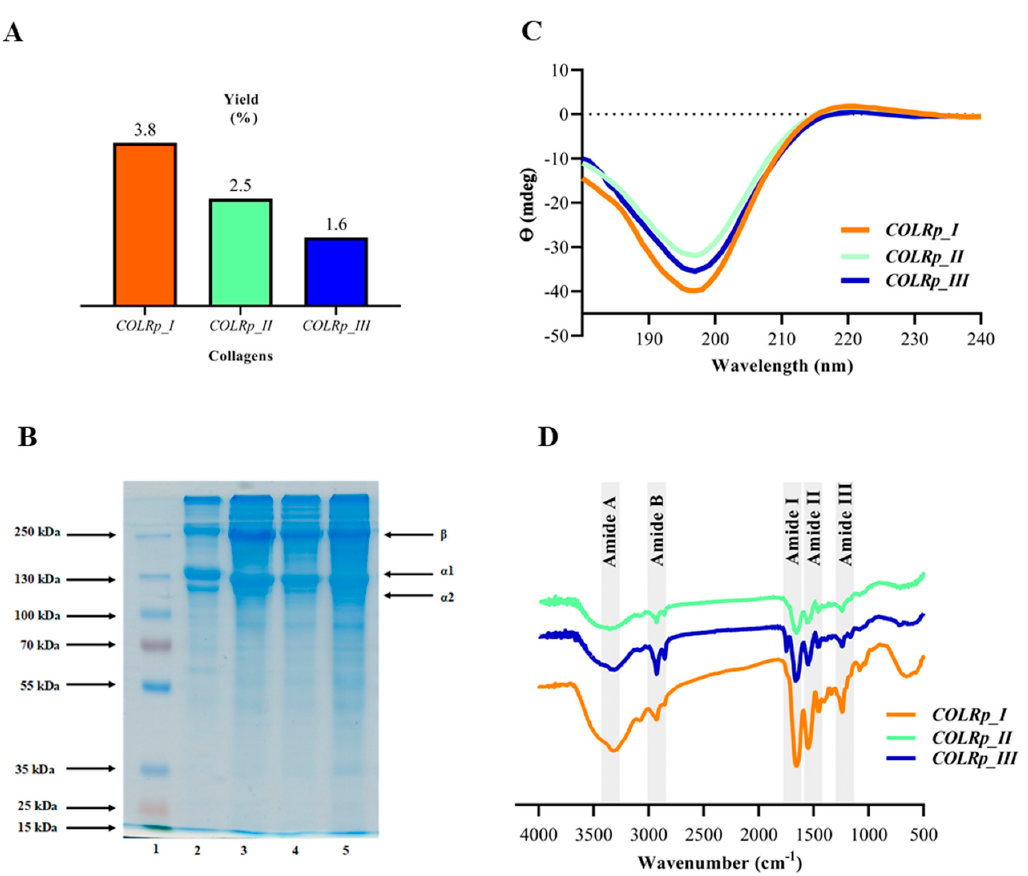
Figure 2. Results from the characterization of R. hippoglossoides fish collagens isolated from skin byproducts using three methods. ( A ) Extraction yield. ( B ) SDS-PAGE gel patterns, whereas number 1 represents protein molecular weight marker; 2 denotes standard collagen from bovine skins ( COL_Bovine ); 3, 4, and 5 represent COLRp_I , COLRp_II, and COLRp_III collagen profiles, respectively. ( C ) Circular dichroism. ( D ) FTIR spectra.